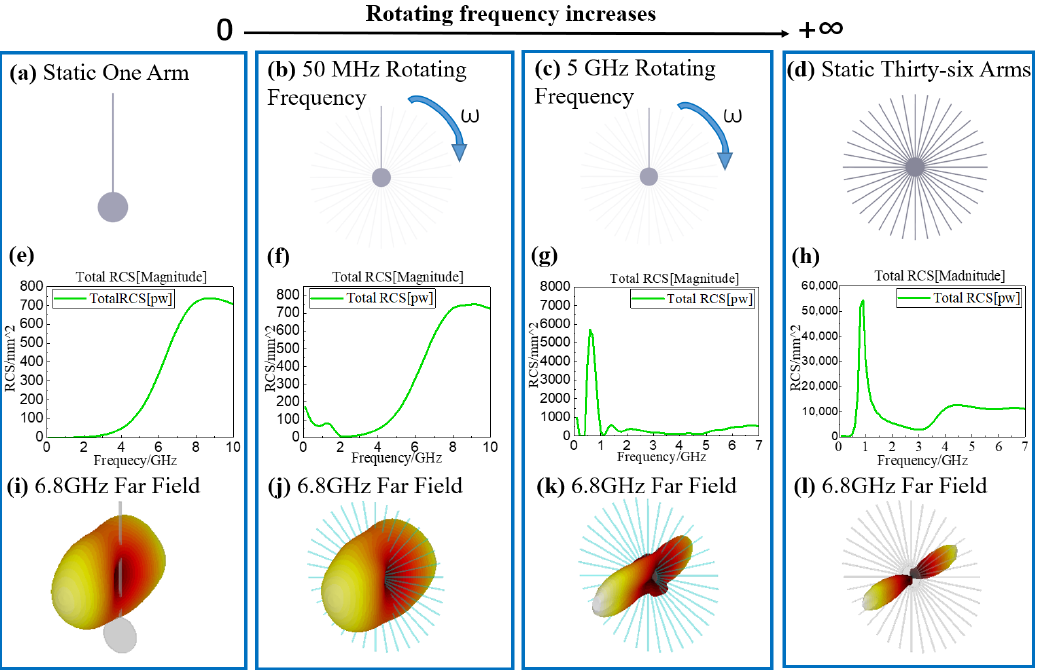
Figure 6. Rapidly rotating propeller: ( a ) Schematic of one rotating arm in the static case, namely the rotating frequency is zero; ( b ) Schematic of one rotating arm with a 50 MHz rotating frequency; ( c ) Schematic of one rotating arm with a 5 GHz rotating frequency; ( d ) Schematic of a static thirty-six- arm structure to mimic the infinite rotating frequency; ( e – h ) the corresponding RCS spectrum; ( i – l ) the corresponding far-field pattern at 6.8 GHz.